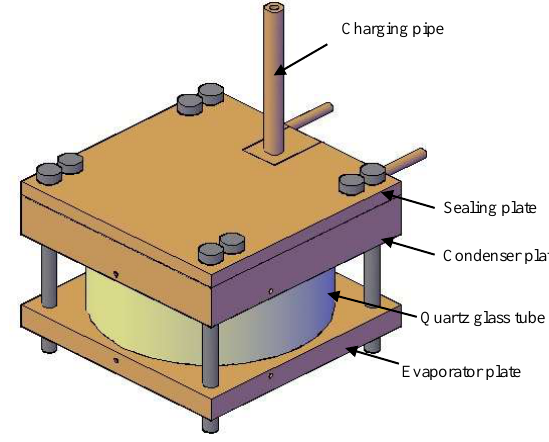
Figure 2. Schematic of flat two-phase thermosyphon. Table 1. The thermophysical properties of de-ionized water (3.17 kPa, 25 °C ).